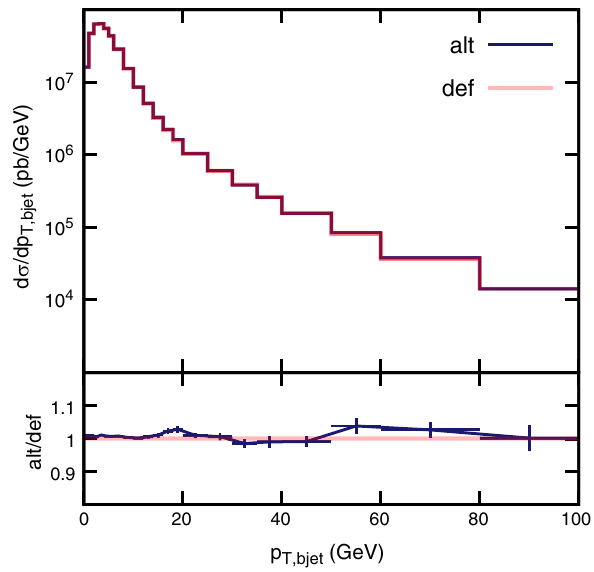
Fig. 9 Comparison of alt and def for the transverse momentum distribution of the b -jet at the 8TeV LHC